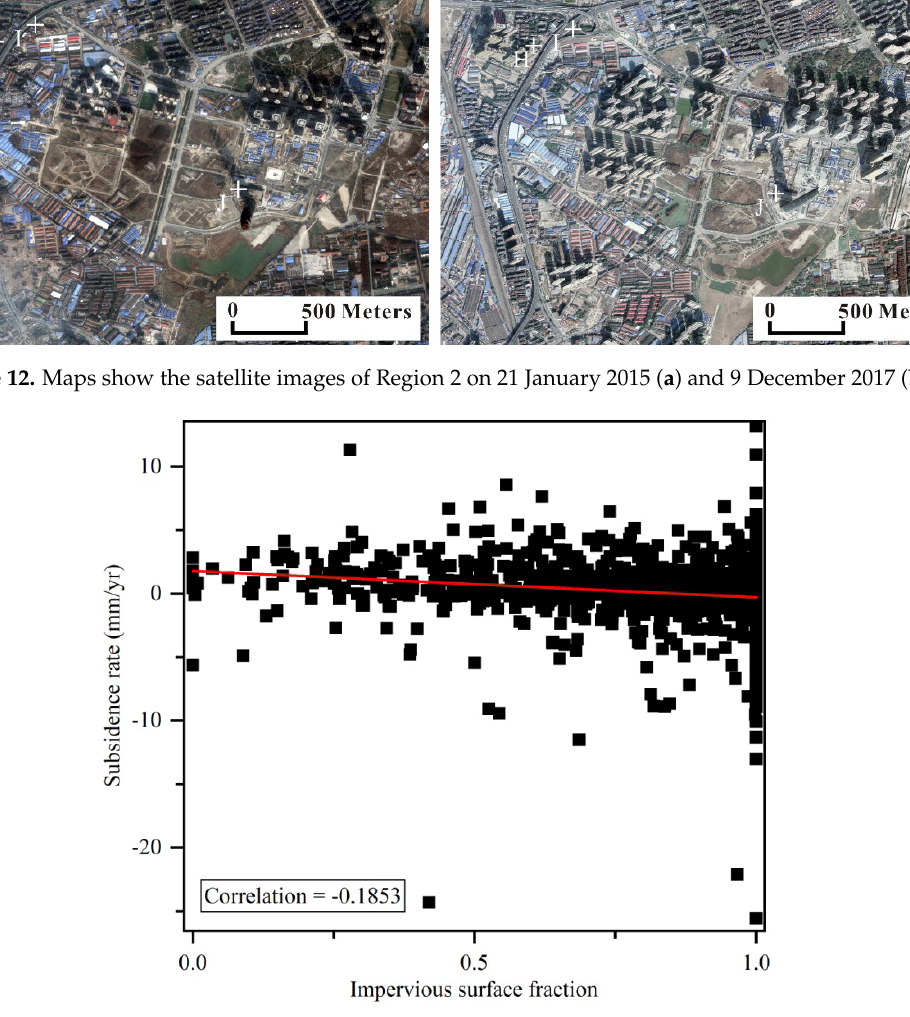
Figure 13. The correlation between subsidence rate and impervious surface fraction.